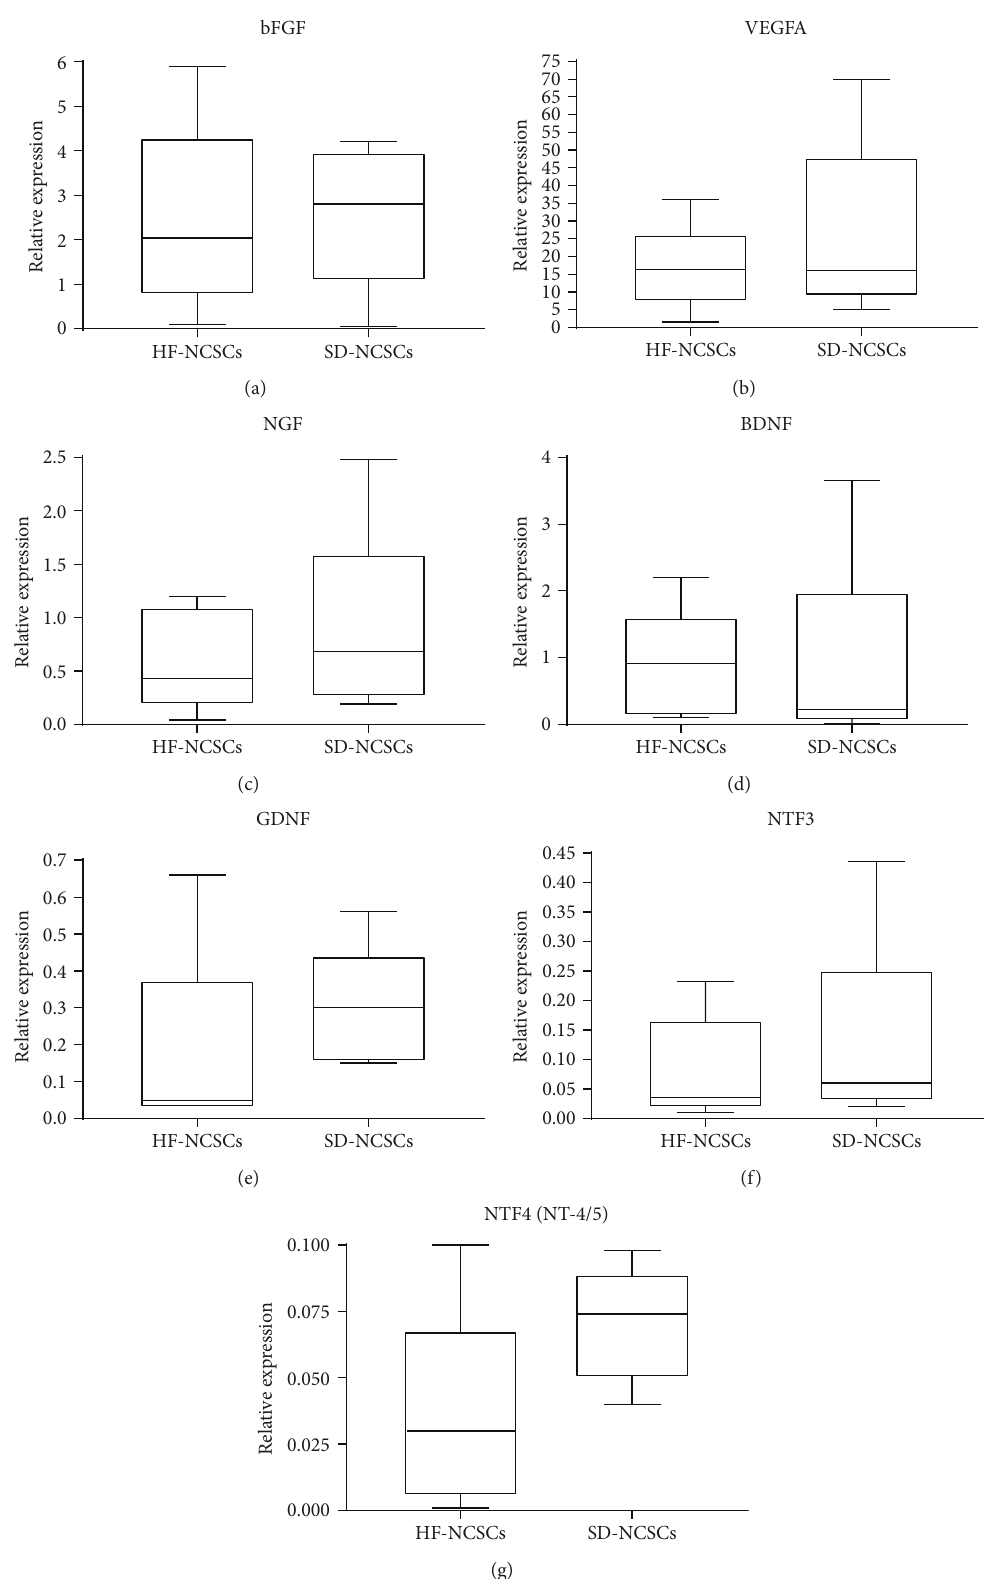
Figure 7: The mRNA expression levels of growth factors in human NCSC cultures isolated from hair follicles and skin dermis; qPCR analysis. The expression of all target genes was normalised to TBP gene expression levels. The HF NCSC and SD NCSC cultures from fi ve donors were analysed. Box plots show quartiles, median, minimum, and maximum